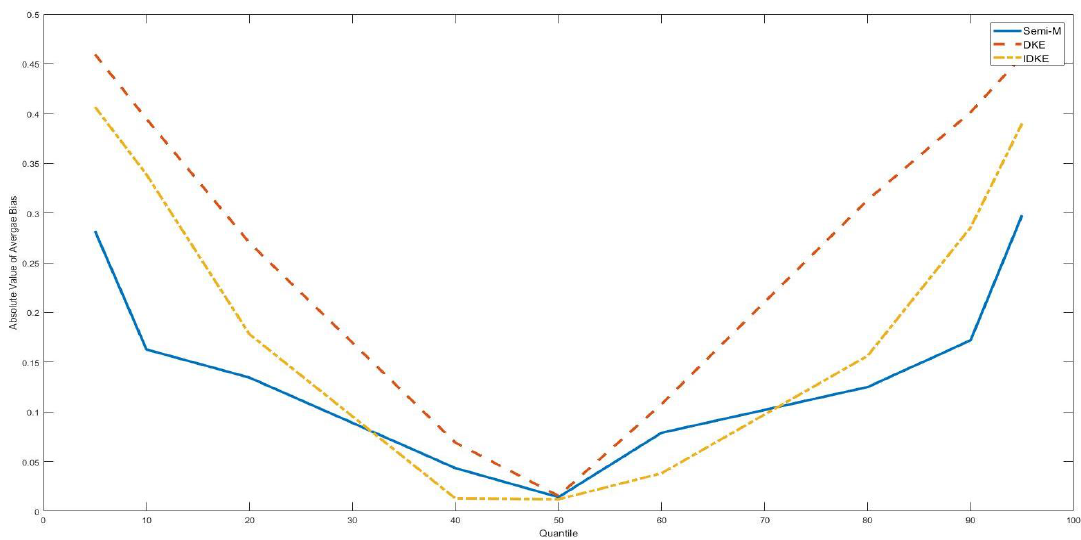
Figure 3. Average bias with γ 0 as various quantiles of the threshold variable, DGP 5, n = 100. This figure shows absolute values of the average bias with the true threshold level being several quantiles of the threshold variable (5th,10th,20th,40th,50th,60th,80th,90th,95th). The simulation is based on DGP 5. The sample size is 100.